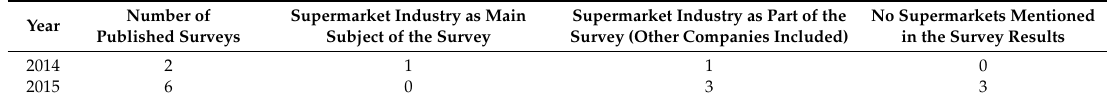
Table 1. Analysis of Surveys by Action on